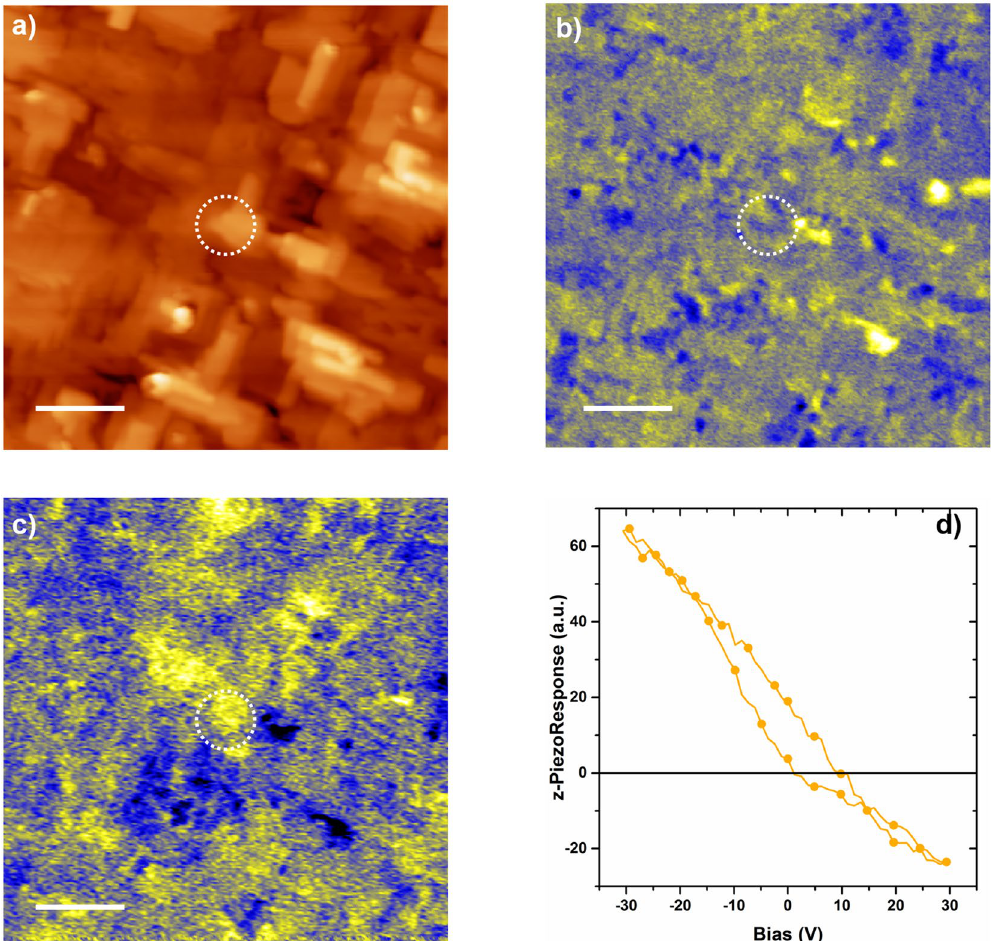
Figure 8. AFM/PFM measurements of BFCO produced with the MS/PLD technique. ( a ) Contact topography AFM image (area 2 μ m x 2 μ m) ( b ) simultaneously recorded out-of-plane PFM image ( b ) and ( c ) in-plane PFM. The z -range is 25 nm for topography; the z-scale for PFM images is in arbitrary units. The scale bar is 400 nm. ( d ) Piezoresponse hysteresis loop recorded from the area highlighted by the dotted